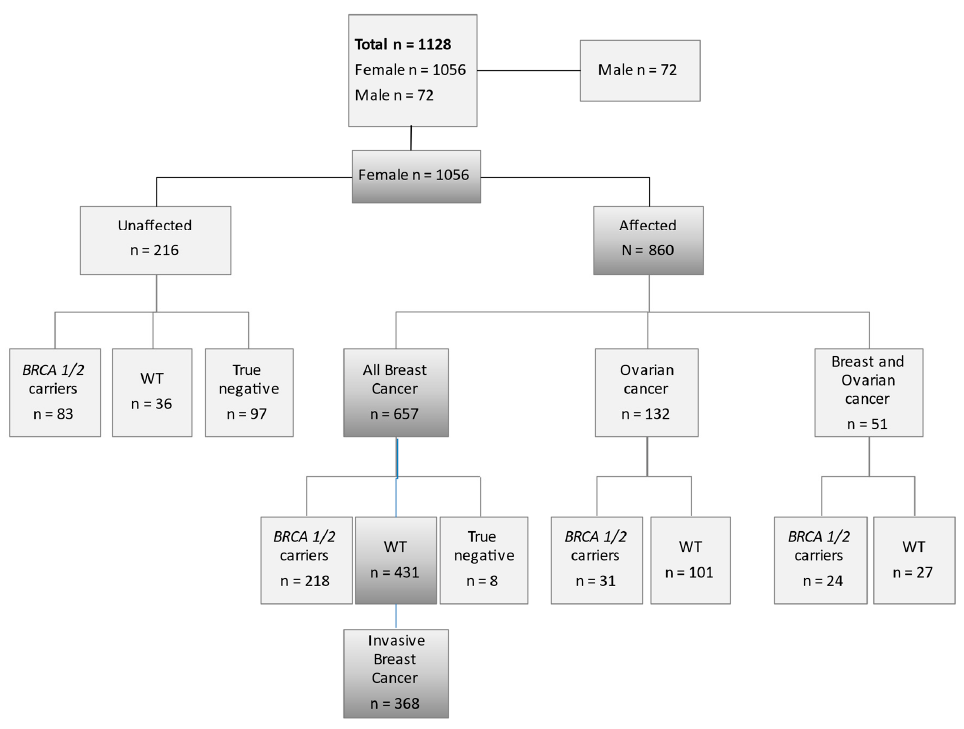
Figure 1. Flow diagram of patient selection. Shaded boxes trace the finial selected cohort. n = number of subjects; WT = wild type.